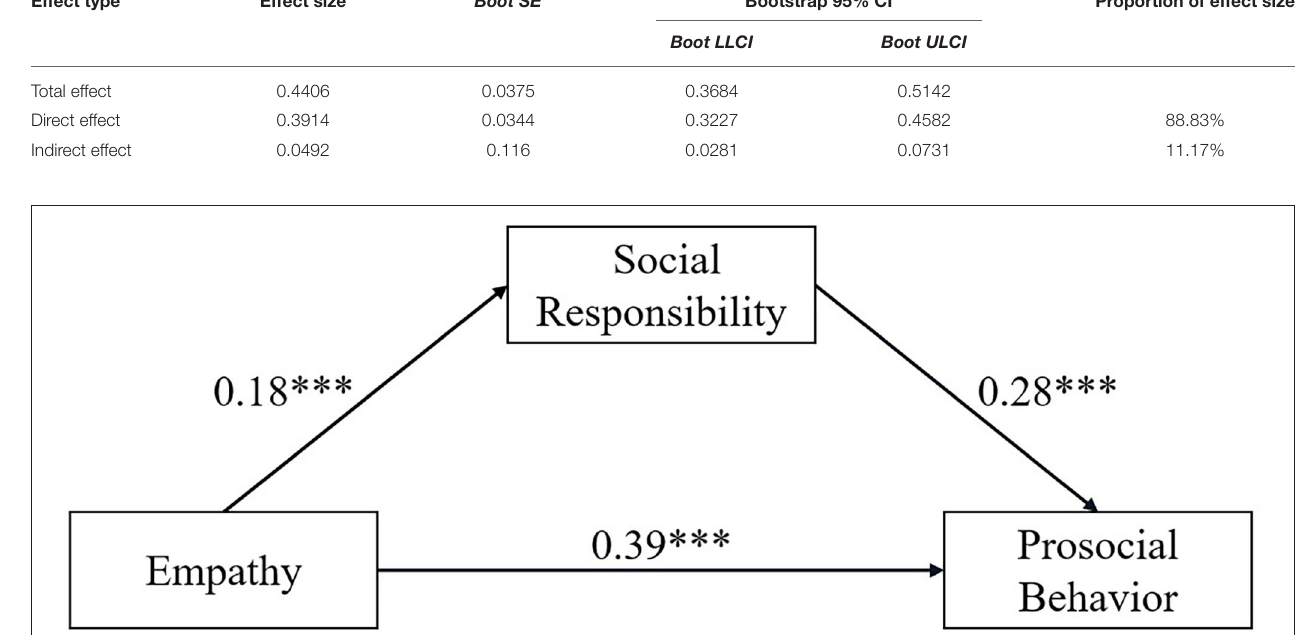
FIGURE 1 | Mediation effect model of social responsibility between empathy and prosocial